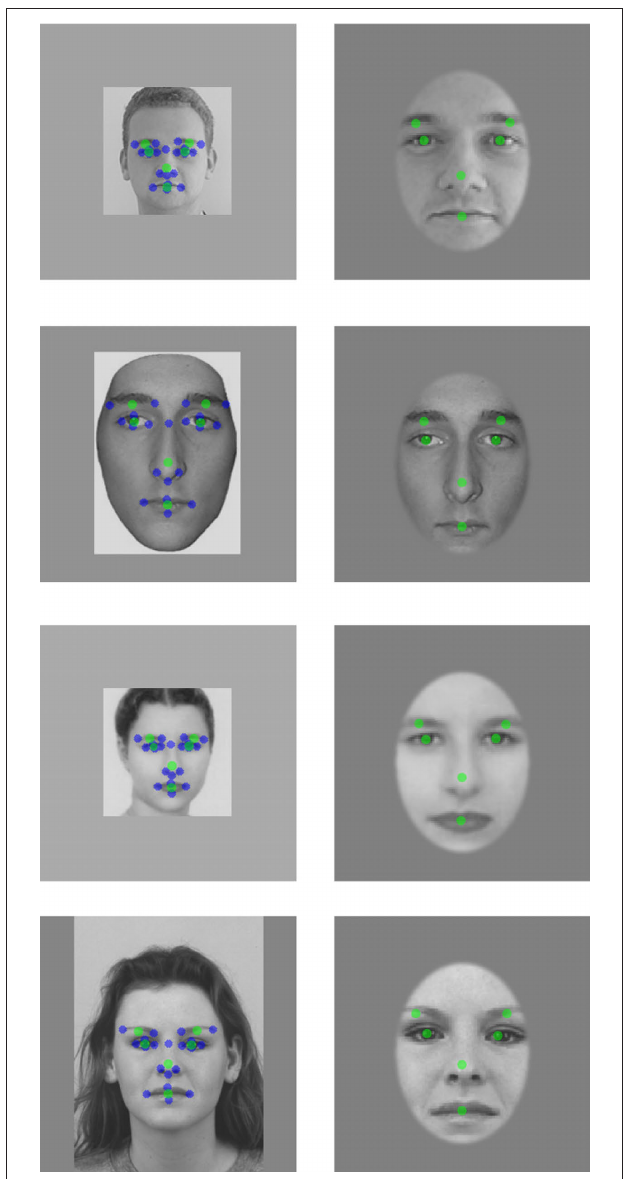
Figure 1 | Annotation and alignement procedure. Leftmost column: Sample faces annotated in Experiment 1. The 20 blue crosses show, for these faces, the average annotations across participants. These 20 annotations were reduced to six attribute positions – green dots – by averaging the coordinates of the annotations belonging to every attribute. Rightmost column: We translated, rotated, and scaled the attribute positions of each face to minimize the mean square of the difference between them and the average attribute positions across faces. The residual differences between aligned attribute positions – green dots – is the interattribute variance in the real-world.